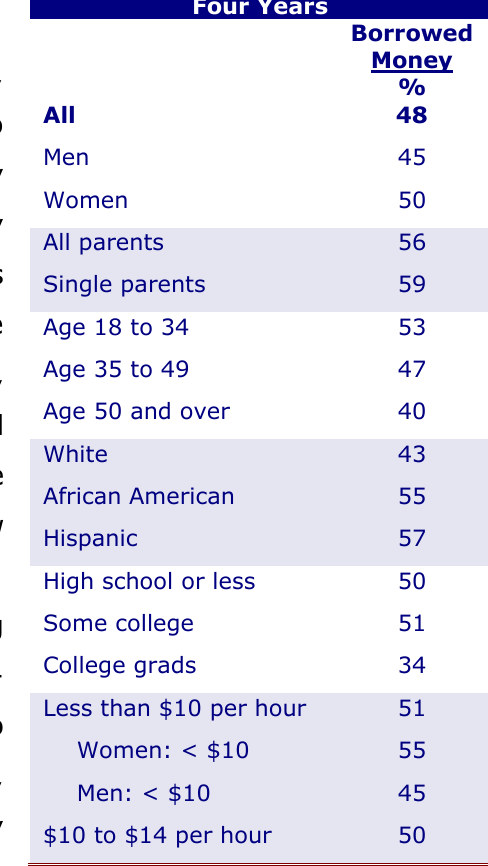
Table 4: Borrowed Money in